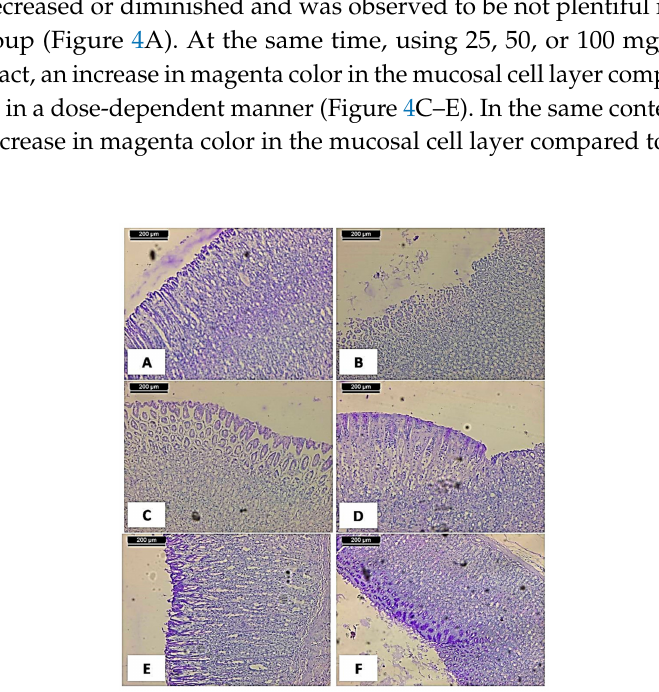
Figure 4. The e ff ects of 70% alcoholic extract of above ground of C. conglomeratus on gastric tissue glycoprotein in ethanol-induced gastric ulcers in rats. ( A ) Normal control showing no accumulation of the magenta color in the mucosal cell layer; ( B ) stomach mucosa of ulcer group showing no accumulation of the magenta color in the mucosal cell layer; ( C , D , and E , respectively): 25, 50, and 100 mg / kg. b.w of 70% alcoholic C. conglomeratus extract showing an increase in magenta color in the mucosal cell layer compared to the ulcerated group in a dose-dependent manner; ( F ) rat treated with Ranitidine showing an increase in magenta color in the mucosal cell layer compared to the ulcerated group (PAS stain, scale bar; 200 µ